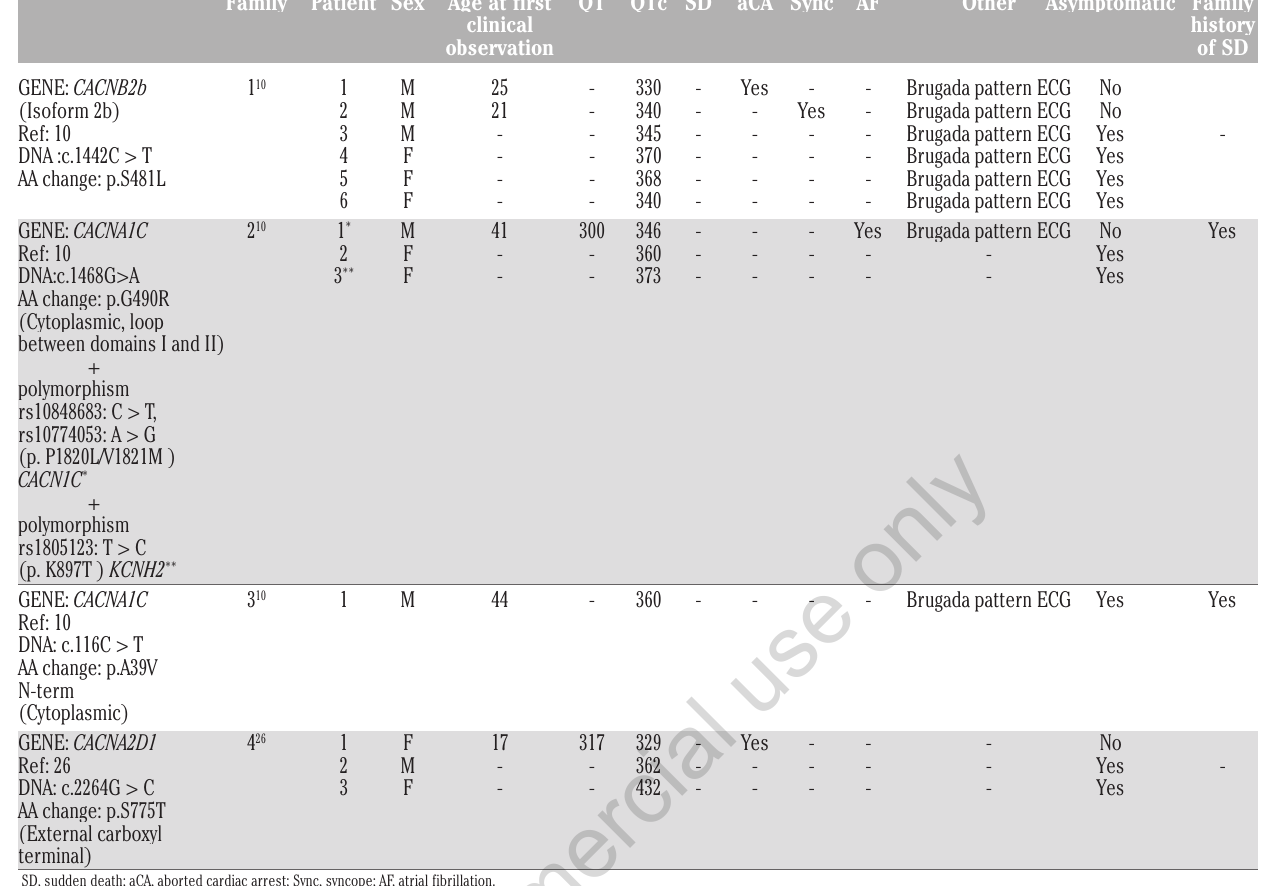
Table 2. Mutations in the calcium channel encoding-genes leading to a shortening of the QT interval. For each subject QT/QTc inter- val, age at first clinical observation and clinical characteristics are reported. Family Patient Sex Age at first Other Asymptomatic Family clinical history observation of SD Brugada pattern